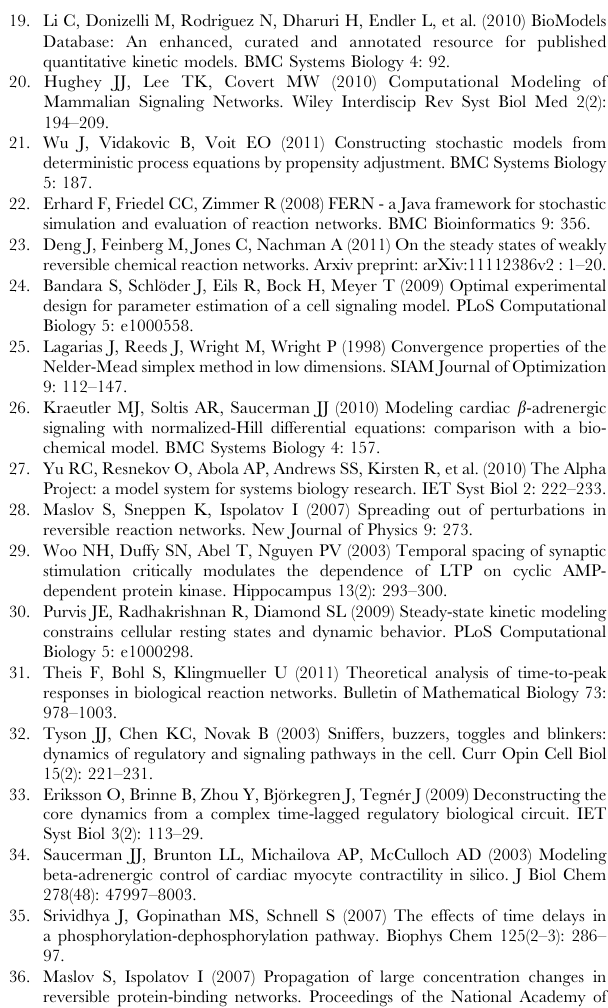
Figure S1 Graph representation of signal transmission. Input concentration for Da is 20 nM … 5 m M , for Ca is 100 nM . There is widespread interconnectedness for low inputs. (EPS) Figure S2 Graph representation of signal transmission. Input concentration for Da is 100 nM , for Ca is 100 nM … 10 m M . The Da/GPCR pathway is clearly separated from Ca